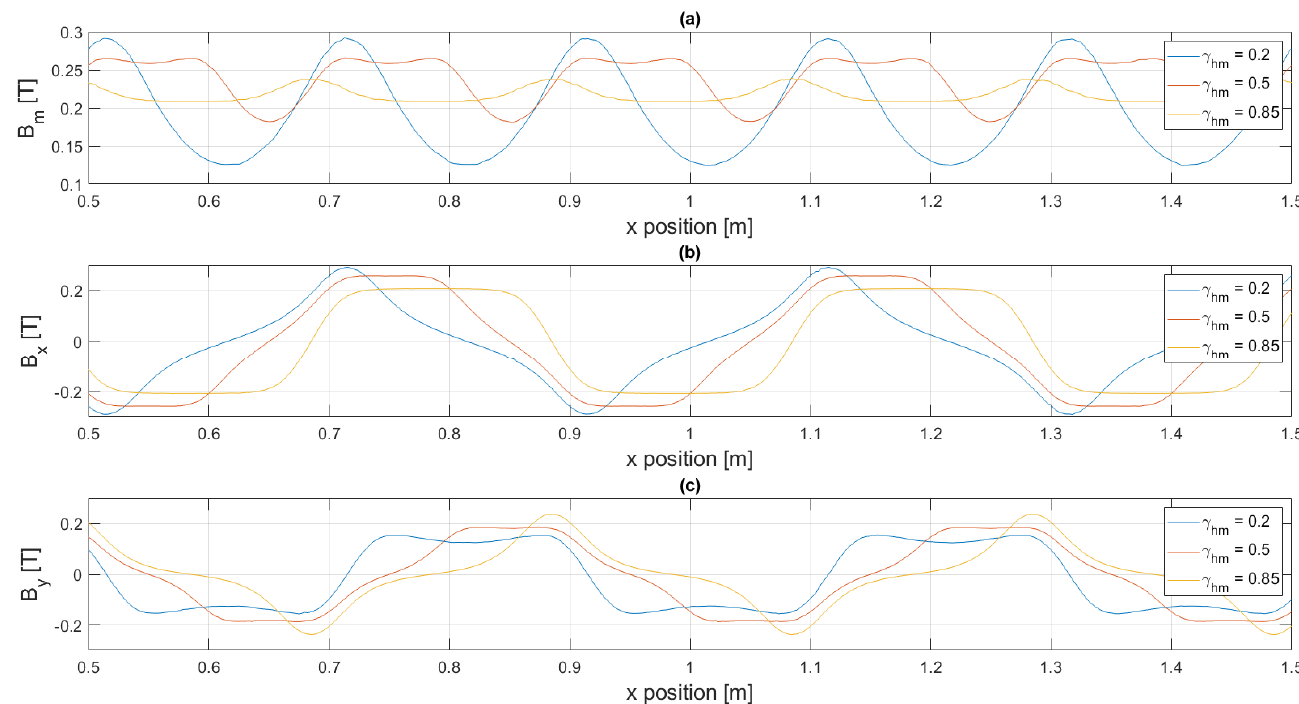
Figure 3. A section of the magnetic field in the air gap beneath the Halbach arrays. ( a ) Magnitude of magnetic induction, ( b ) x component of magnetic induction and ( c ) y component of magnetic induction. Table 2. Comparison of average vales of magnitude of magnetic induction for different cases of fill